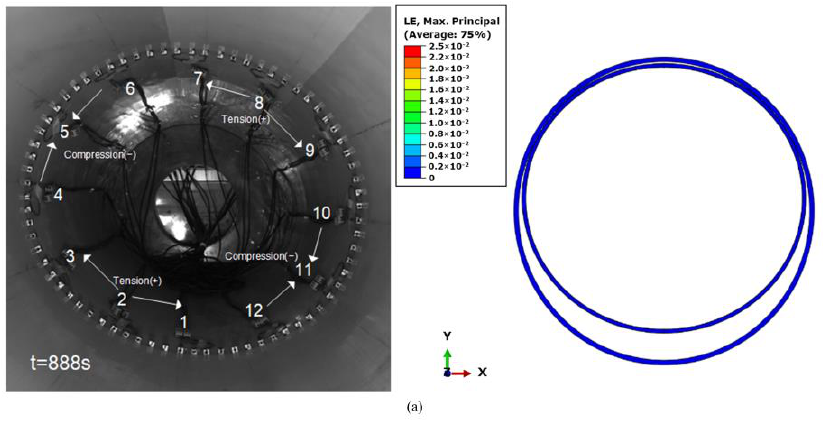
Figure 5. Comparing the pressure–displacement curves of test and simulation divided into floating stage (AB), buckling stage (BC) and failure stage (CD).